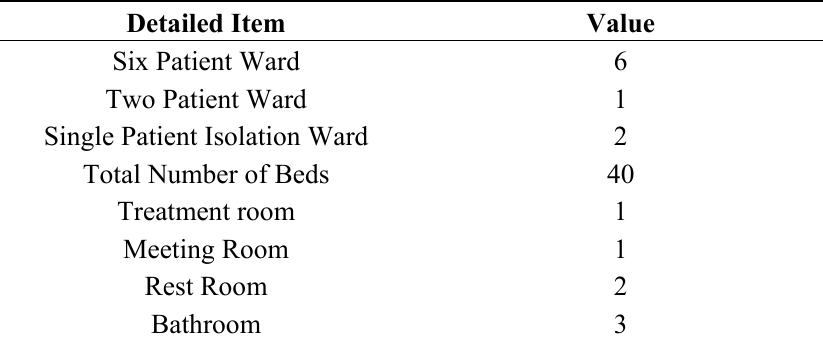
Table 3. Typical setting of nursery ward.